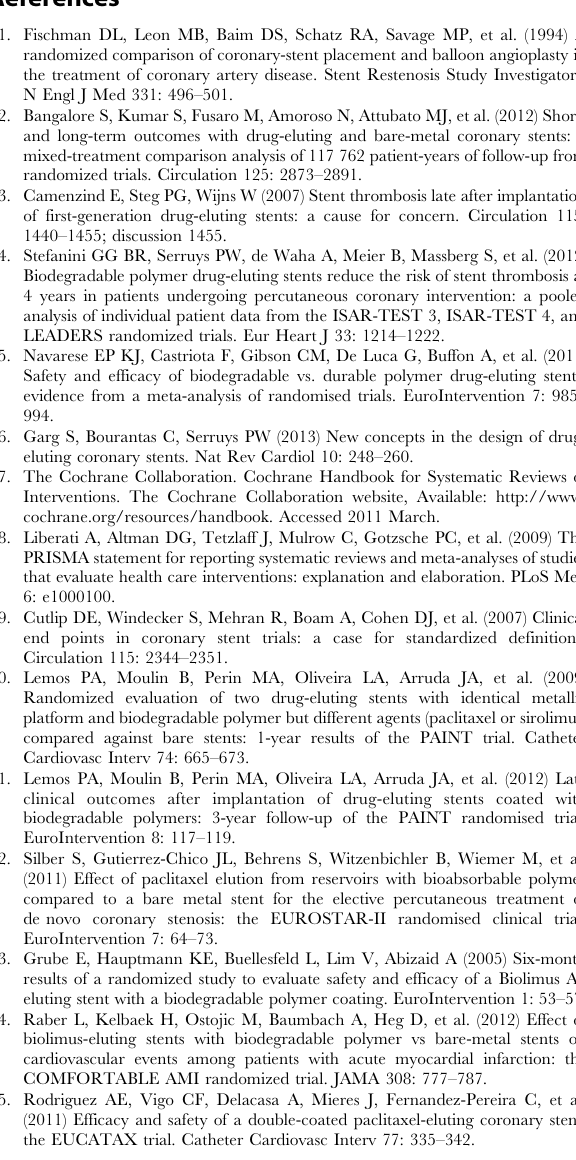
Figure S20 Individual and summary odds ratios for TVR in patients treated with BP-SES vs. BMS. (JPG) Figure S21 Individual and summary odds ratios for late define stent thrombosis in patients treated with BP-SES vs. BMS. (JPG) Table S1 Protocols of dual anti-platelet therapy